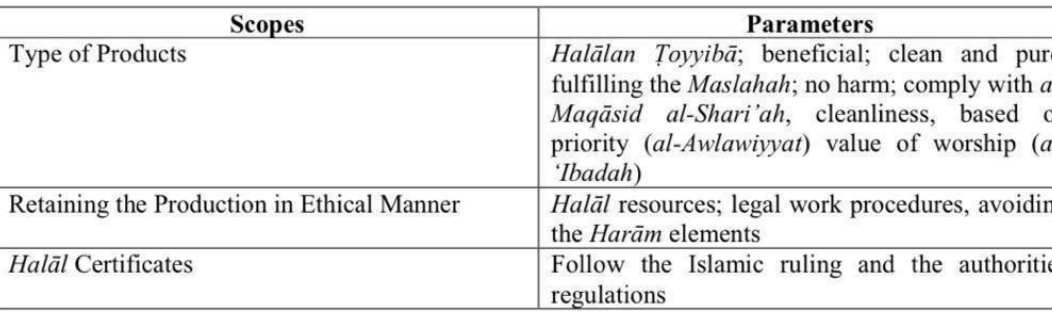
Figure 2. The Parameters of Islamic Business Ethics in Production